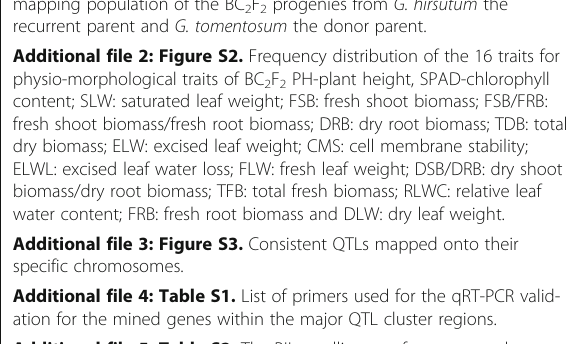
Additional file 1: Figure S1. Flow chart of the development of the mapping population of the BC 2 F 2 progenies from G. hirsutum the recurrent parent and G. tomentosum the donor parent.